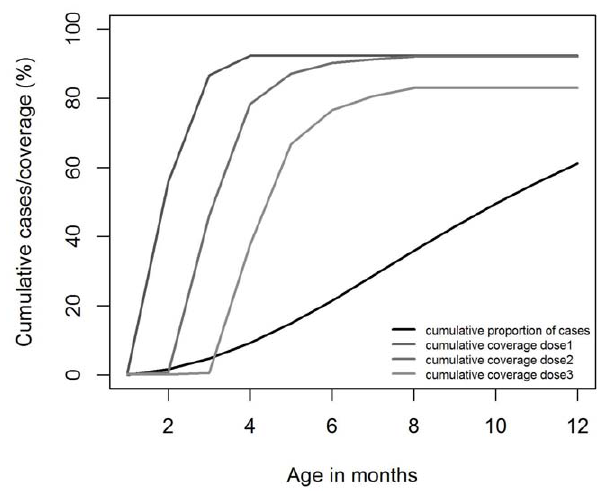
Figure 1. The cumulative coverage of one, two and three doses of vaccine (lines of decreasing greyness) and the cumulative proportion of mortality (dark grey) by month of age over the first year of